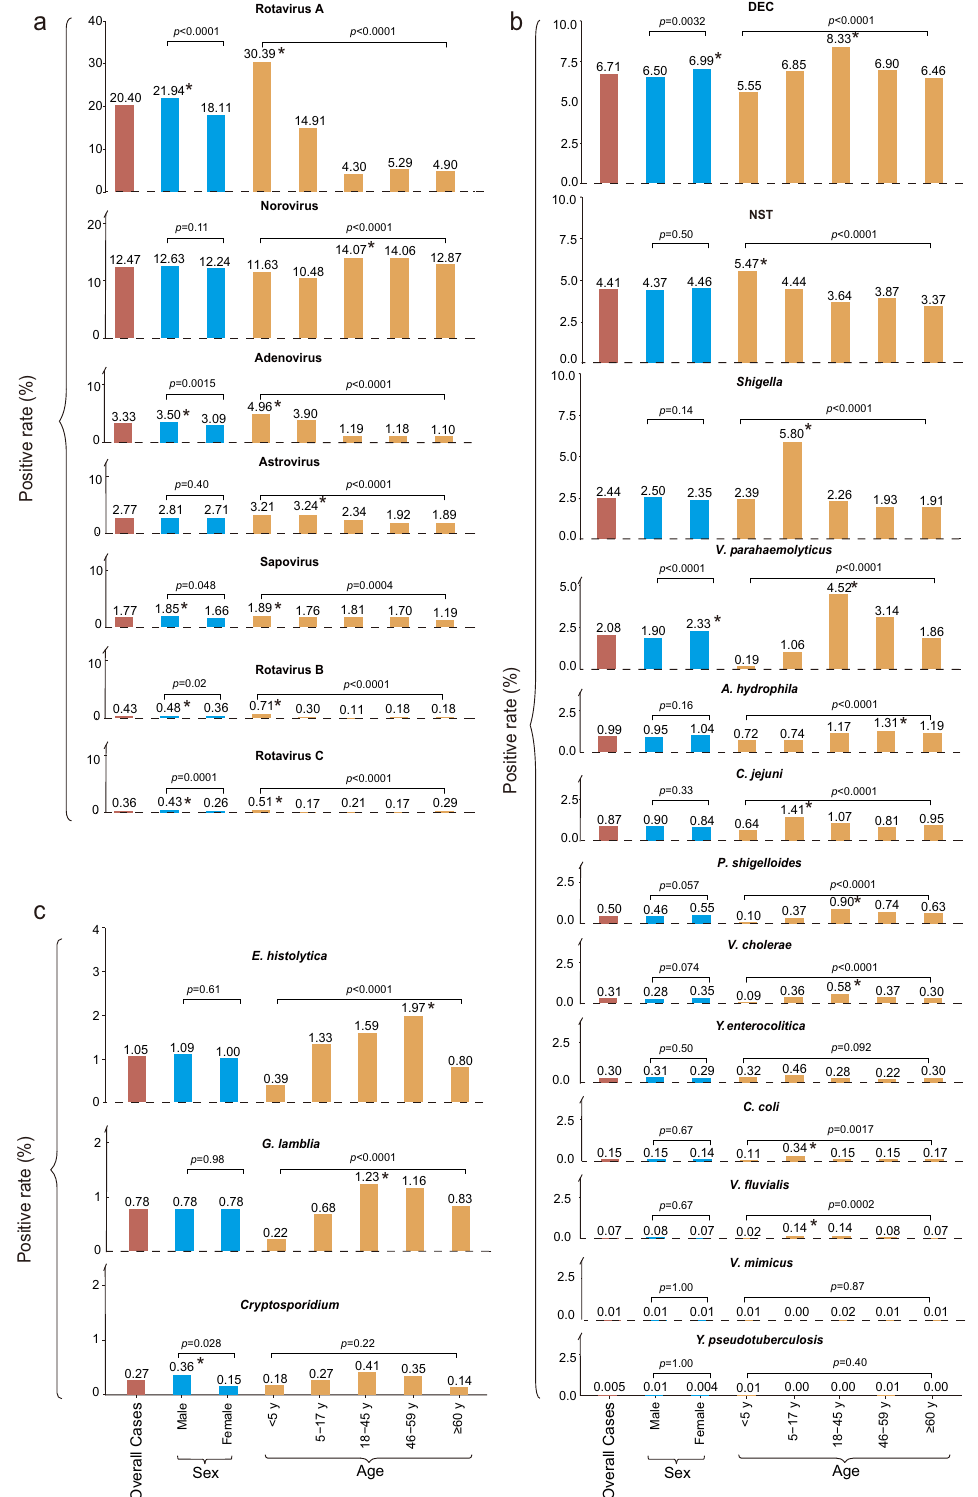
Fig. 3 Positive rate of pathogens by sex and age in patients with diarrhea in China, 2009 ‒ 2018. a Viral pathogens. b Bacterial pathogens. c Parasite pathogens. The lengths of red bars indicate the positive rate of each pathogen. The lengths of blue bars and yellow bars indicate the positive rate of each pathogen by sex and age groups. The same group was marked by the same colors of bars fi lling. *Indicates a signi fi cant difference (chi-square test or Fisher ’ s exact test were two-sided and p < 0.05 was statistically signi fi cant) found within the group. DEC diarrheagenic Escherichia coli ; NTS nontyphoidal Salmonella . Source data are provided as a Source Data fi